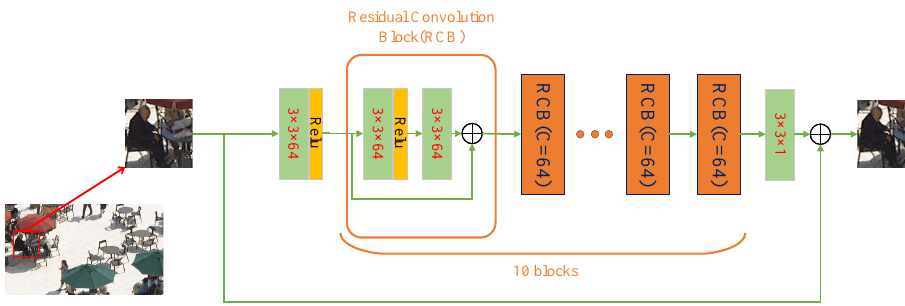
Figure 6. Framework of an